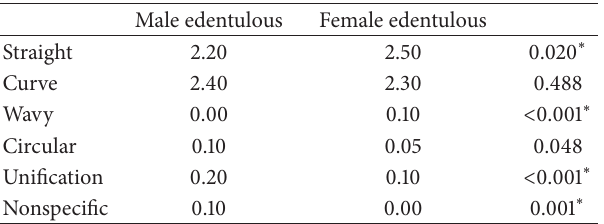
Table 1: Table showing the mean value of different rugae patterns among edentulous subjects.